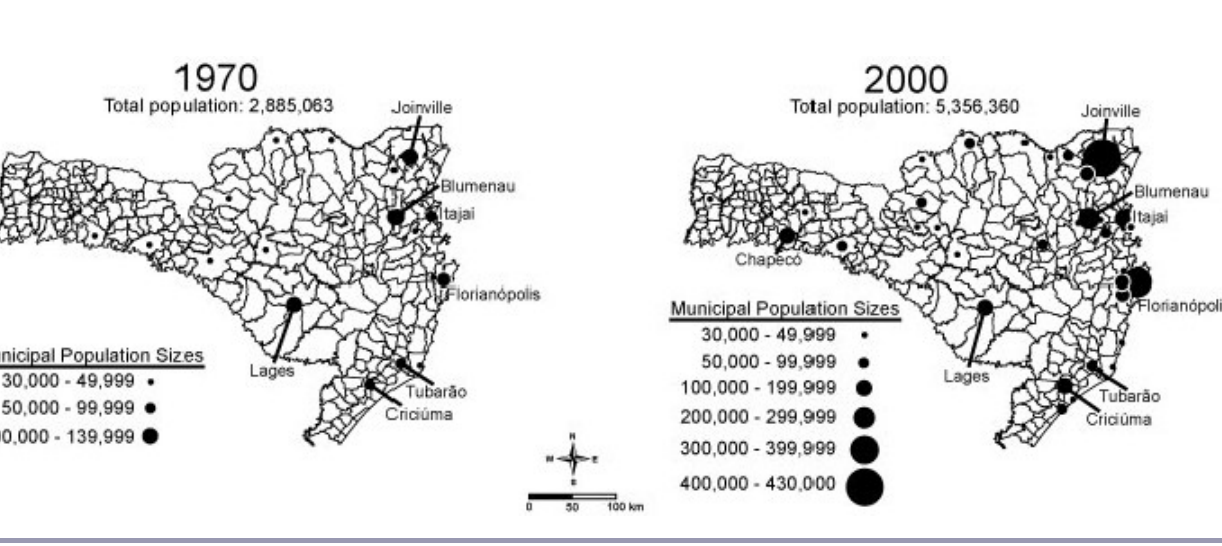
Fig. 5. Distribution of municipalities in Santa Catarina with > 30,000 inhabitants in 1970 and 2000. Source: Instituto Brasileiro de Geografia e Estatística (1974 b,